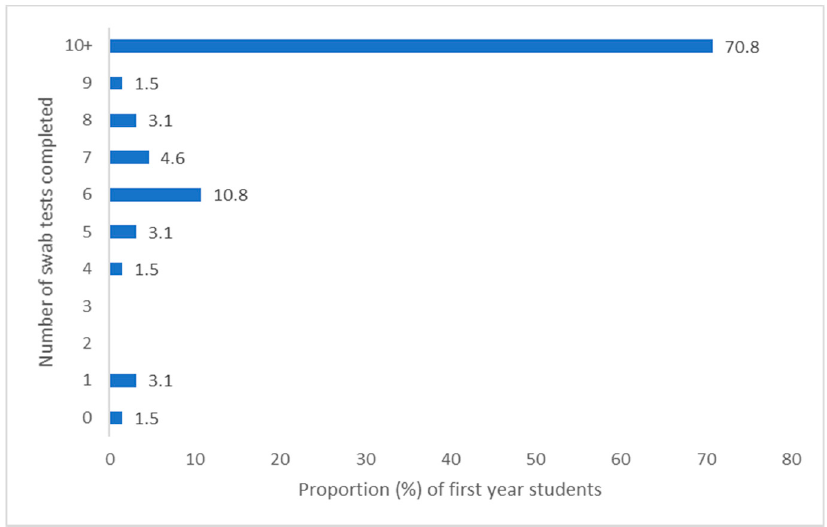
Figure 2. Proportion of year one students completing between 0–10 swab tests during P-ATS.